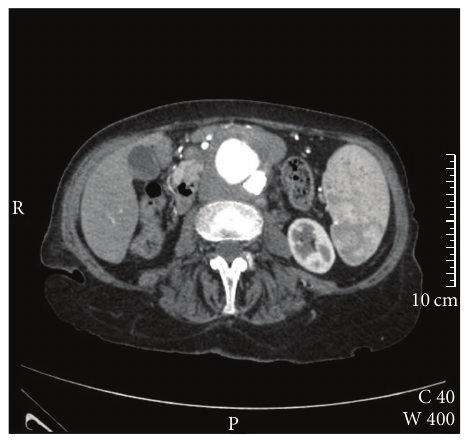
Figure 1: CT scan of the abdominal aorta demonstrating a mycotic aneurysm below the renal arteries.